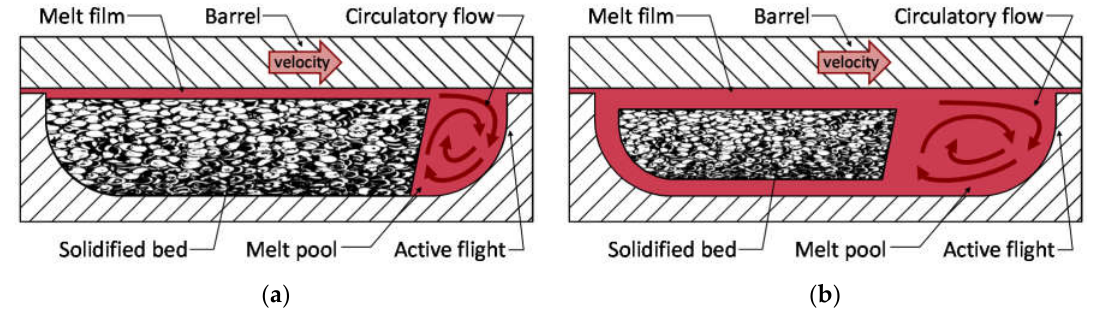
Figure 1. ( a ) Tadmor melting model; ( b ) Five‐zone melting model.